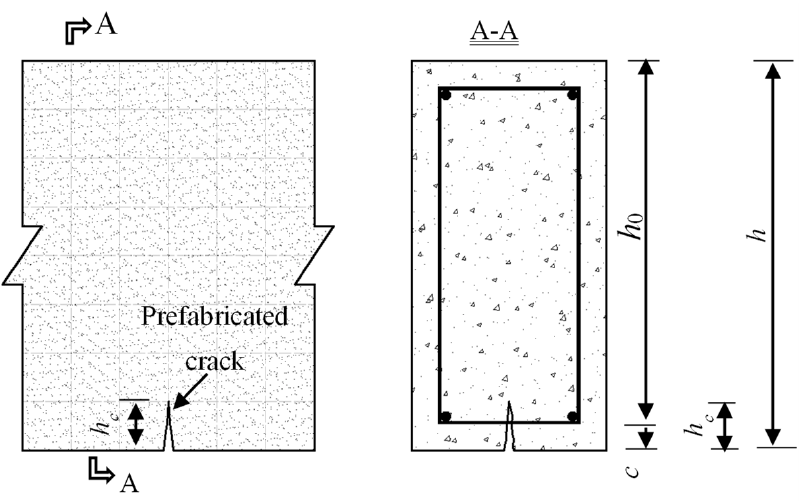
Figure 18. Schematic diagram of the cross section of pre-cracked beam.